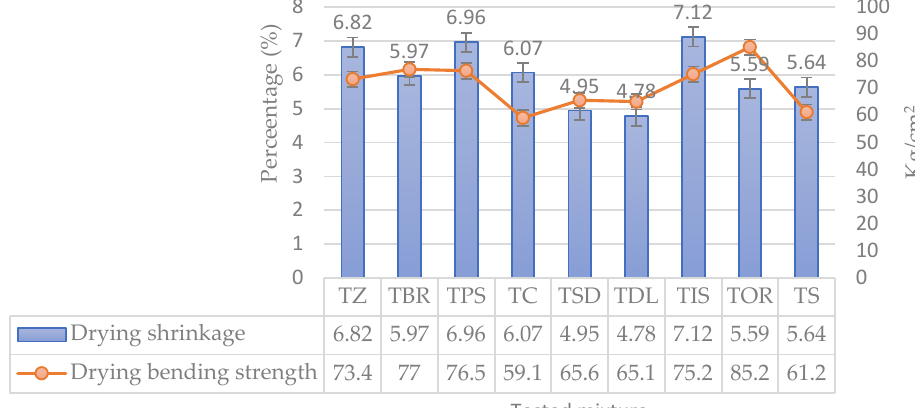
Figure 8. Plasticity by Pfefferkorn and necessary extrusion water for all mixtures.